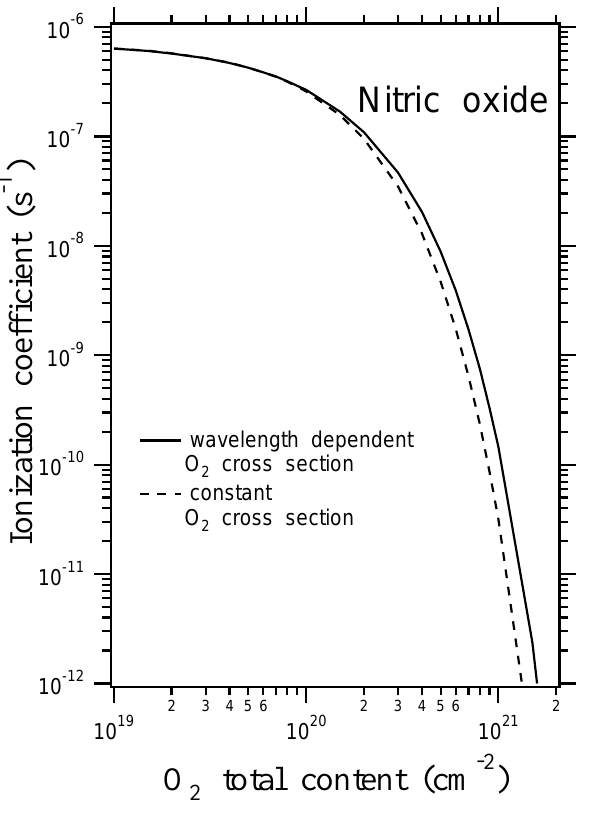
Fig. 10. Nitric oxide ionization coefficient as a function of O 2 total content (see text for an explanation of the two curves).